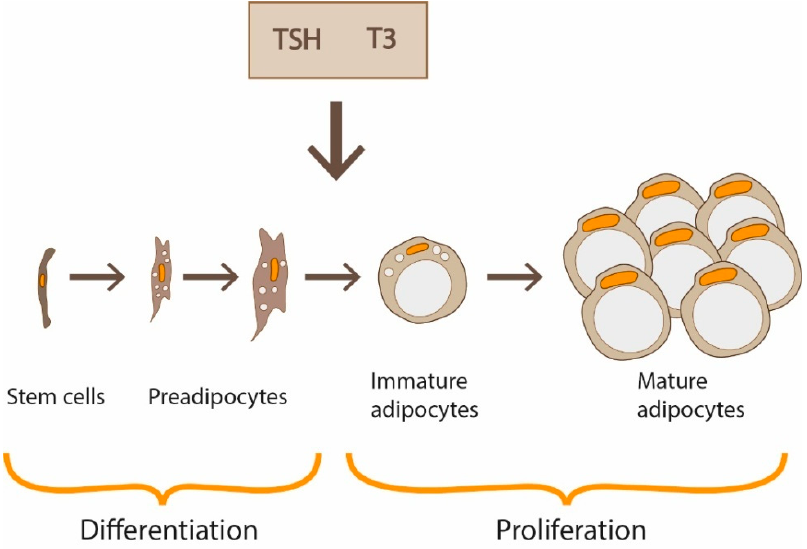
Figure 2. Adipose tissue grows by two mechanisms: hyperplasia (increased number of fat cells) and hypertrophy (increased adipocyte volume). The differentiation of progenitor cells through preadipocytes into adipocytes, as well as the proliferation of adipocytes, is also under TSH/THs control. It has long been thought that BAT occurs only in newborns and then